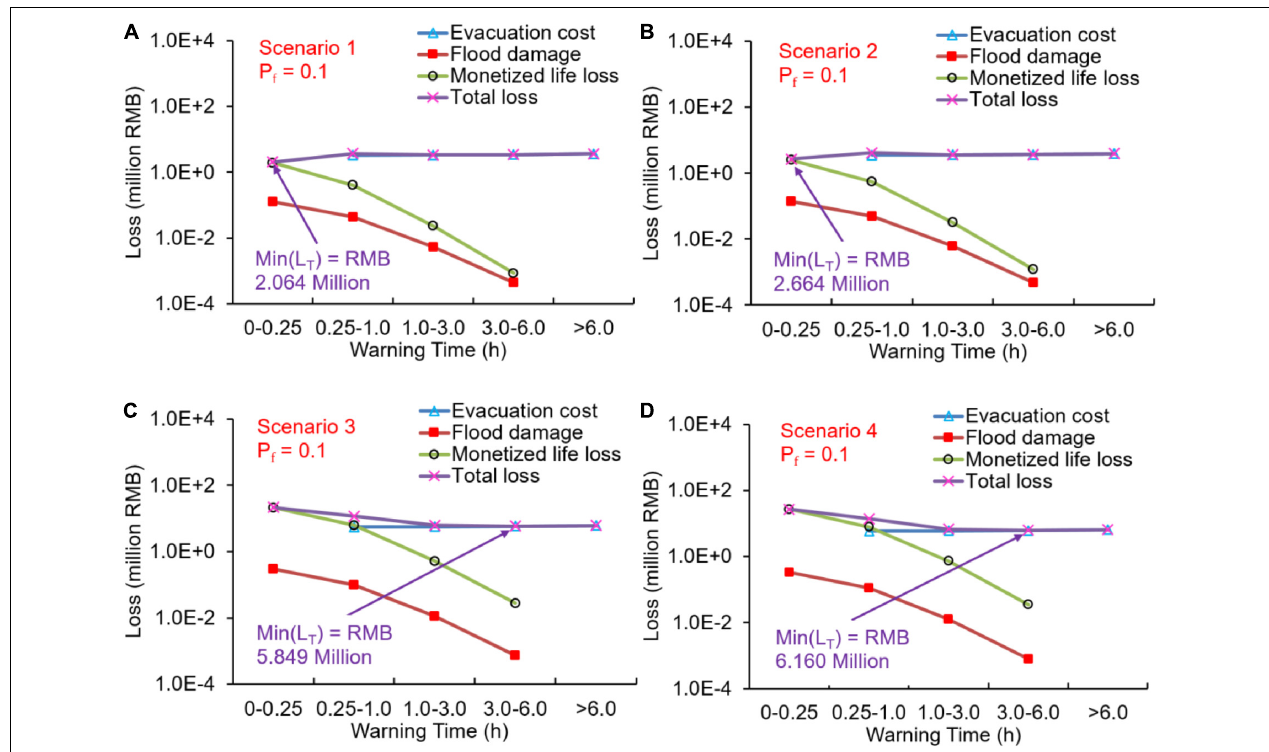
FIGURE 10 | Three types of losses and the expected total loss ( L T ) vary with warning time in the four scenarios when the dam failure probability ( P f ) is 0.1: (A) Scenario 1, (B) Scenario 2, (C) Scenario 3, and (D) Scenario 4.